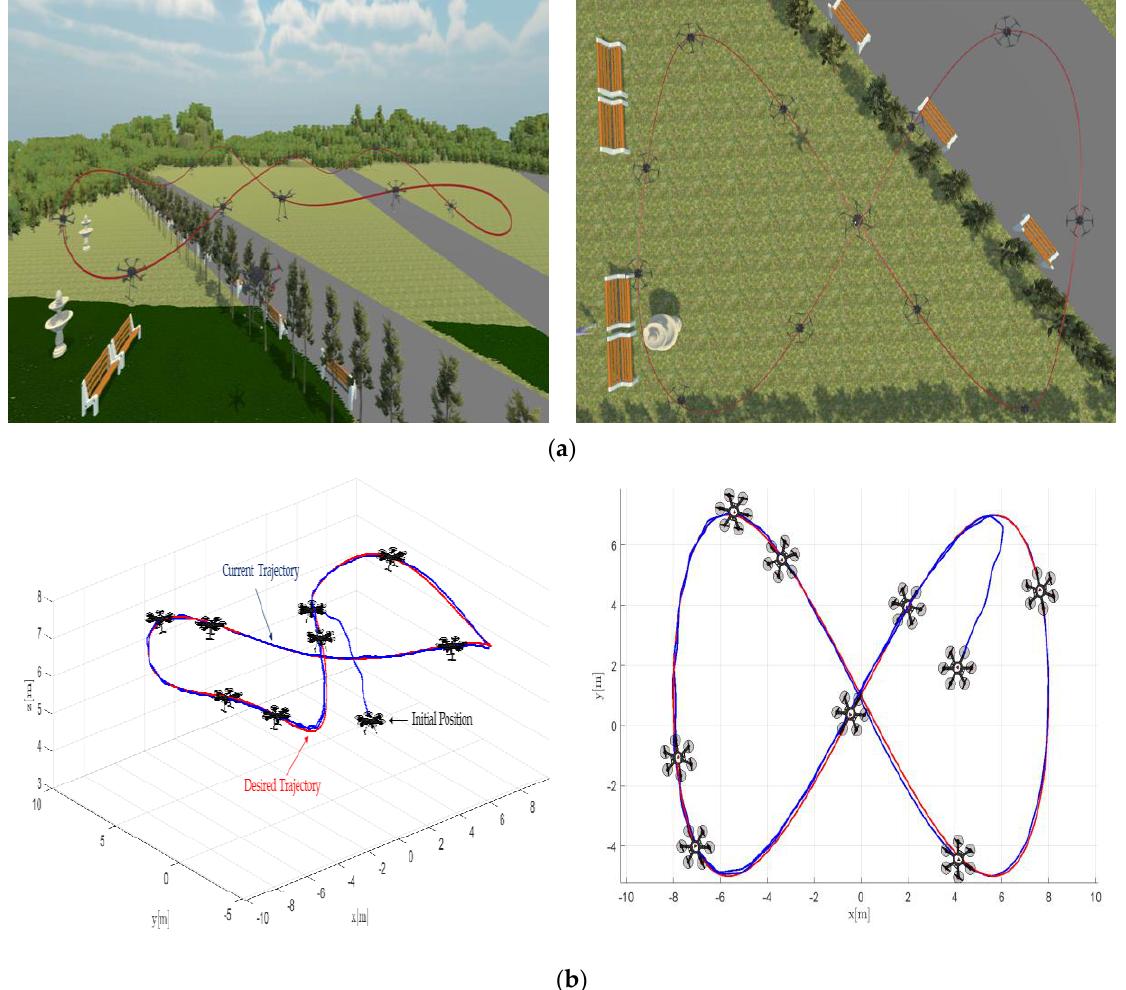
Figure 10. Stroboscopic movement of the UAV. ( a ) UAV stroboscopic flight based on simulated data; ( b ) UAV stroboscopic flight based on real experimental data.